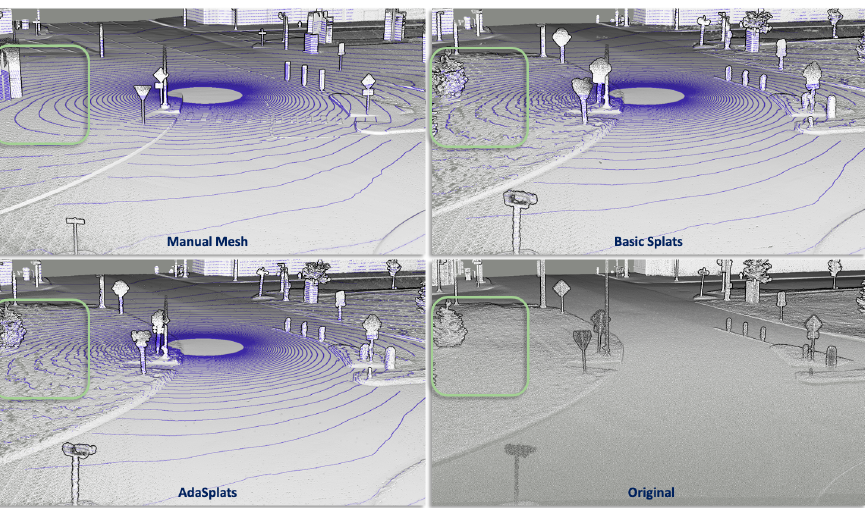
Figure 13. Comparison of simulated LiDAR data using different reconstruction and modeling methods on M-City. The top row shows the simulation in the manually meshed scene ( left ) and the modeled scene with Basic Splats ( right ). The bottom row shows the simulation with AdaSplats-GT ( left ) and original point cloud ( right ). Modeling vegetation is not an easy task and usually requires different ray–primitive intersection